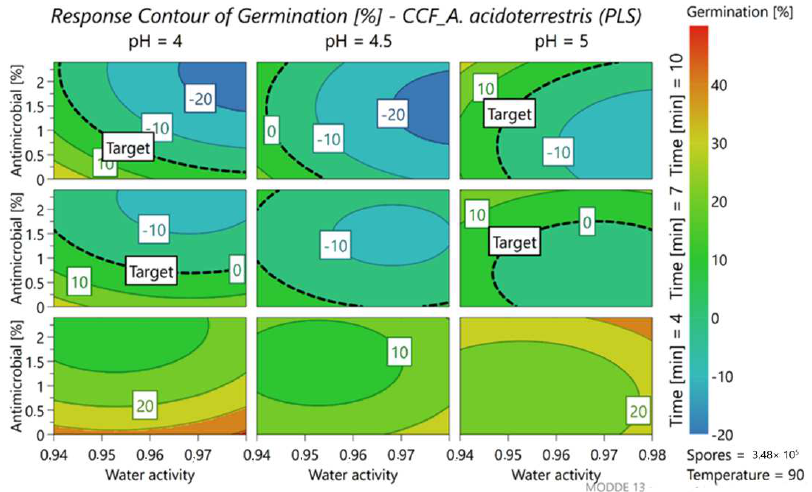
Figure 3. Contour plot representing the percent of germination of A. acidoterrestris LMG 16906, at different levels of parameters.